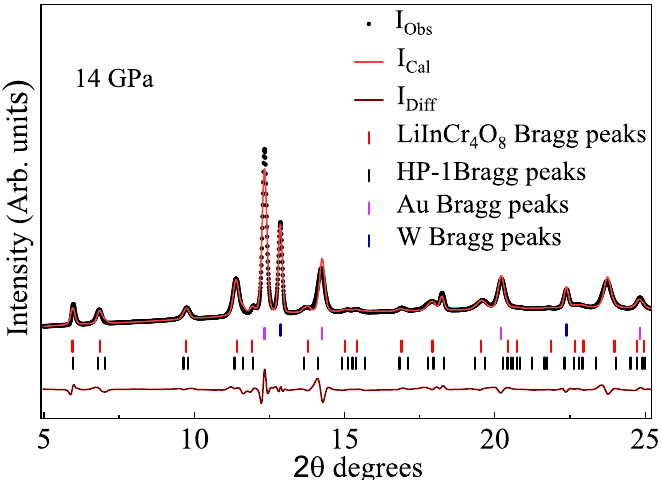
Figure 6. Rietveld refinement of the XRD pattern at ∼ 14 GPa, demonstrating the coexistence of the HP-1 (space group I¯4m2) phase with the ambient pressure cubic